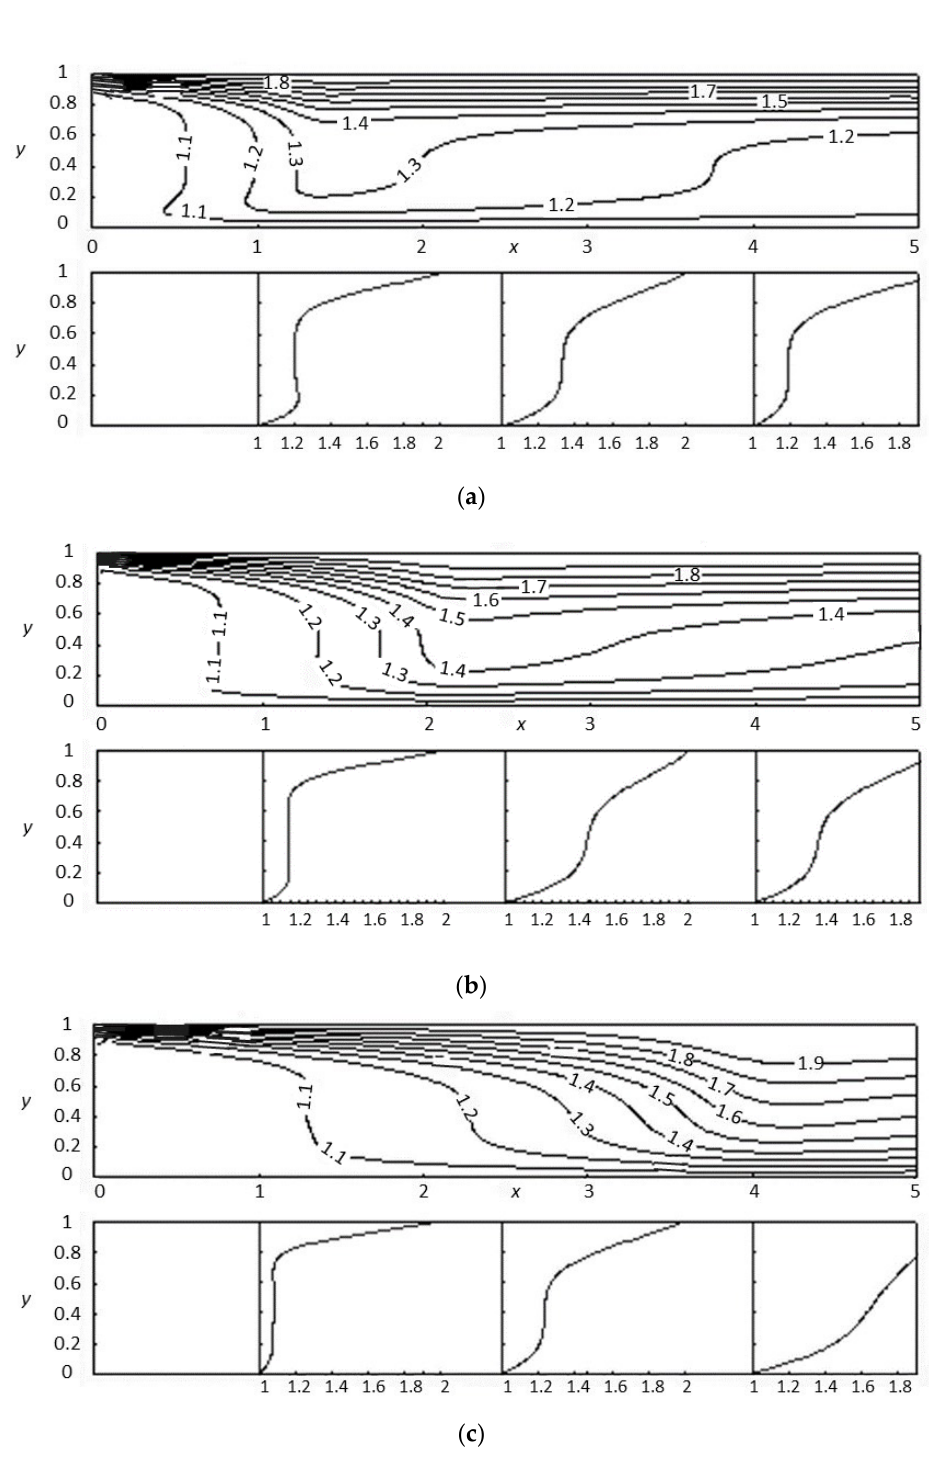
Figure 8. Contours of field temperature taken at different dimensionless times: ( a ) 0.57; ( b ) 1.0; ( c ) 2.0.